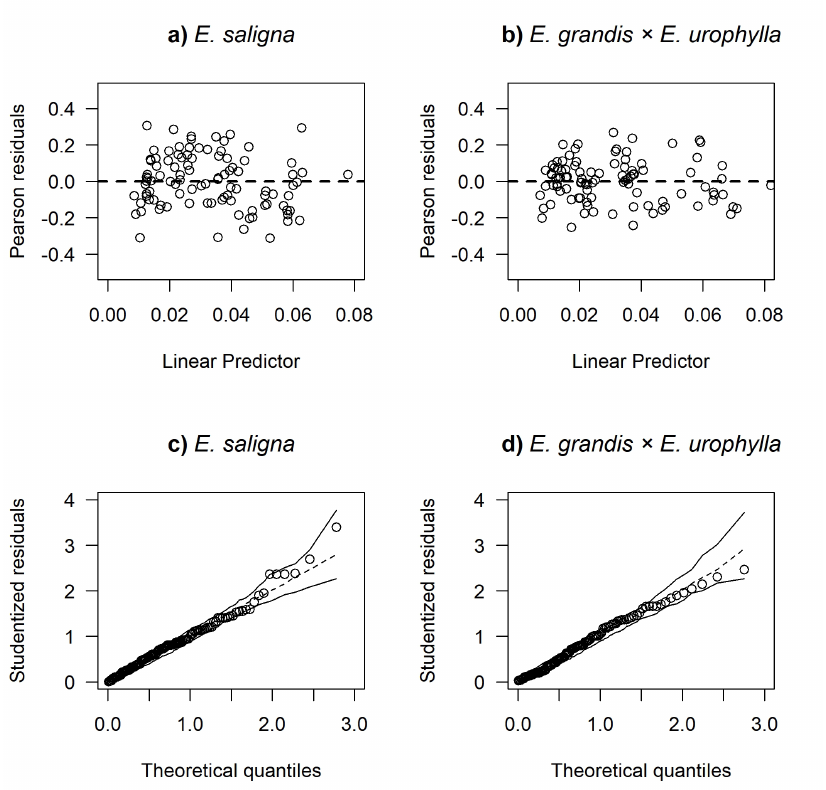
Figure 3 - Pearson’s residuals in E. saligna ( a ) and E. grandis × E. urophylla ( b ) stands and half-normal plots in the residual biomass estimation of wood harvesting in E. saligna ( c ) and E. grandis × E. urophylla ( d )